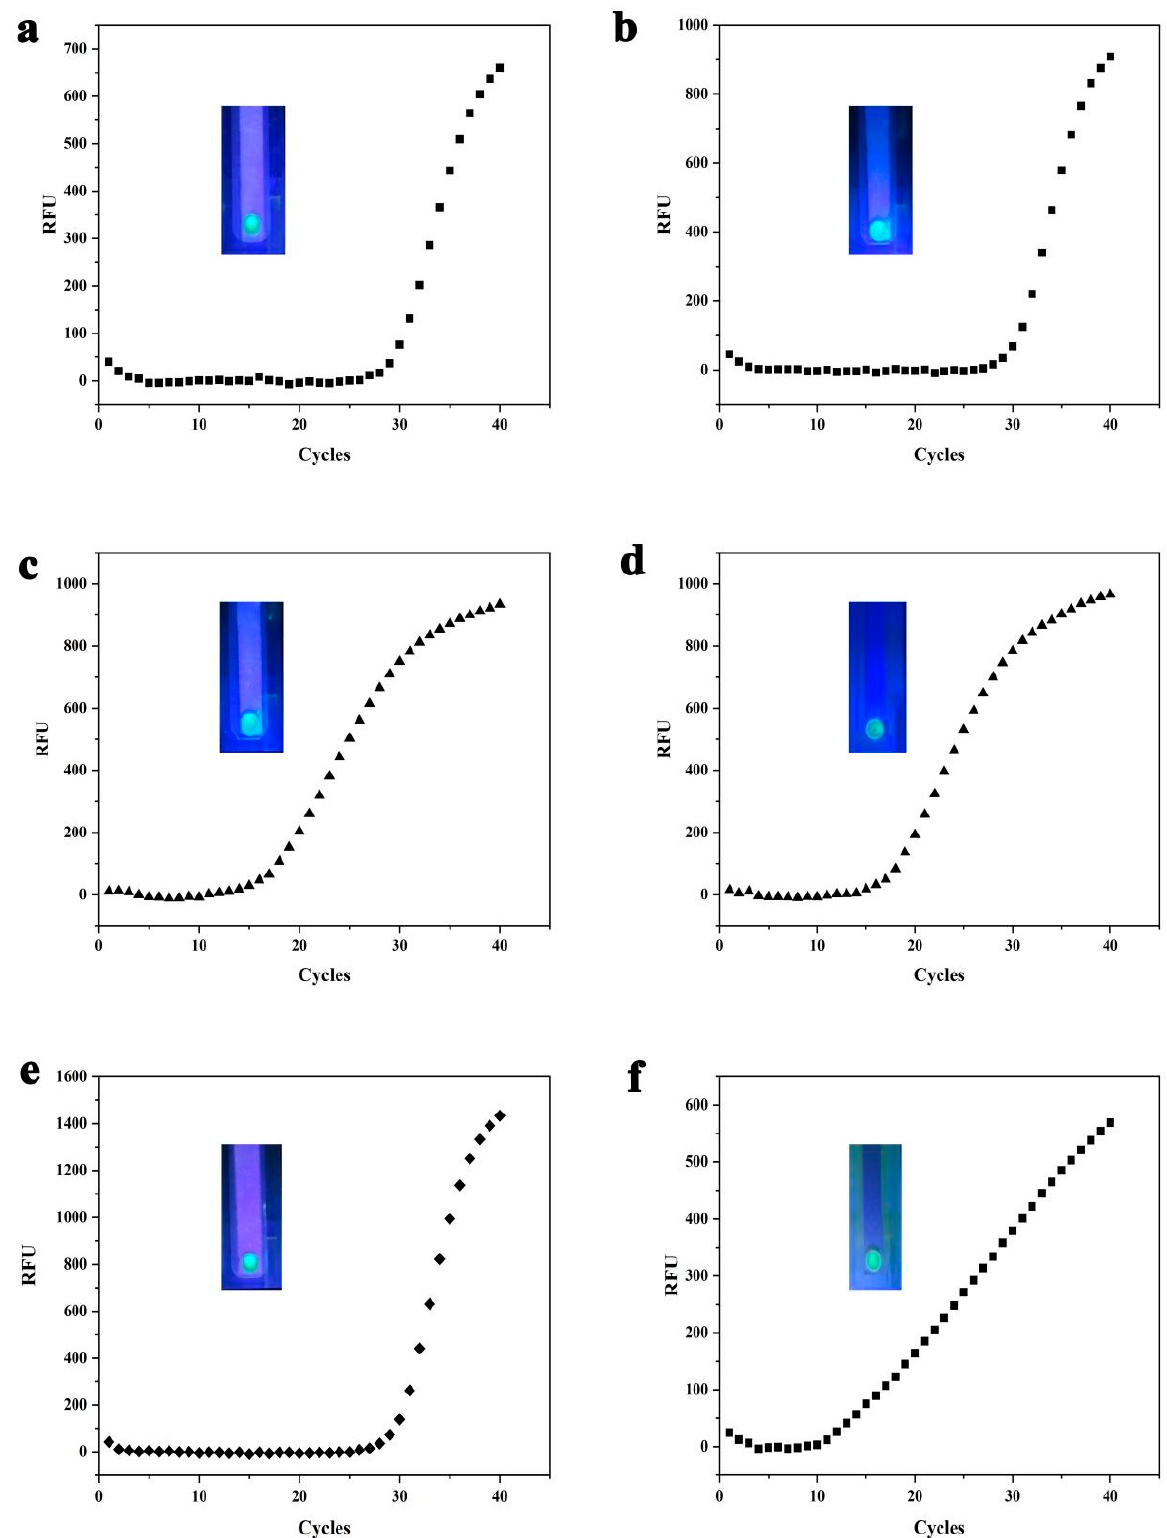
Figure 6. On-site detection results of SMART: ( a ) test results of M2 samples (the GM maize DR12-5); ( b ) test results of M5 samples (the GM maize DR12-5); ( c ) test results of M7 (duck meat); ( d ) test results of M9 (duck meat); ( e ) the test results for M21 (Ac); ( f ) the test results for M28 (Ac).